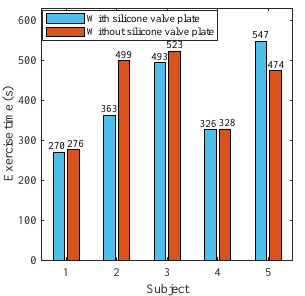
Figure 13. The exercise time of 10 tests in movement mode.